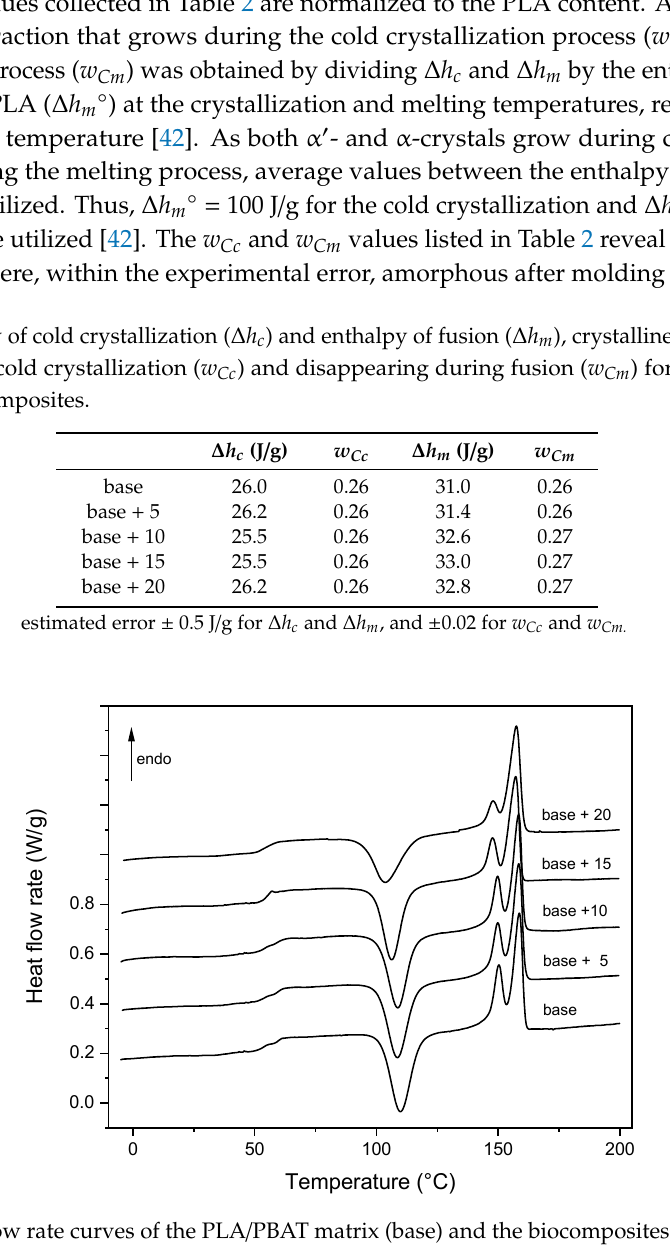
Figure 4. Heat flow rate curves of the PLA / PBAT matrix (base) and the biocomposites with increasing mussel shells content, as a function of the temperature. The ordinate values refer only to the bottom curve. All the other curves are shifted vertically for the sake of clearness. Table 2. Enthalpy of cold crystallization ( Δ h c ) and enthalpy of fusion ( Δ h m ), crystalline weight fraction growing during cold crystallization ( w Cc ) and disappearing during fusion ( w Cm ) for the PLA/PBAT matrix and biocomposites.